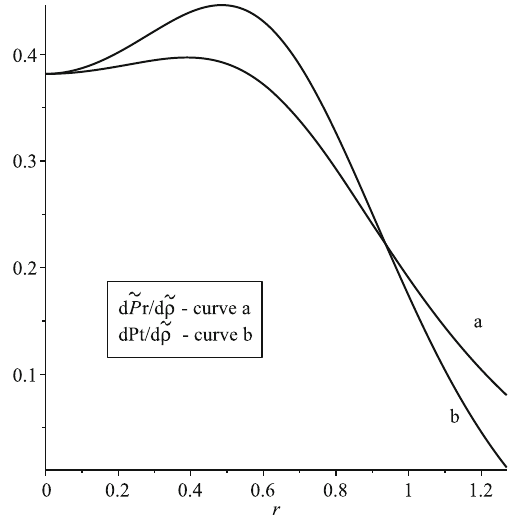
Fig. 16 Gradient of the energy density for the solution obtained with the second algorithm with ˜ F = 0 from the isotropic Gold III solution